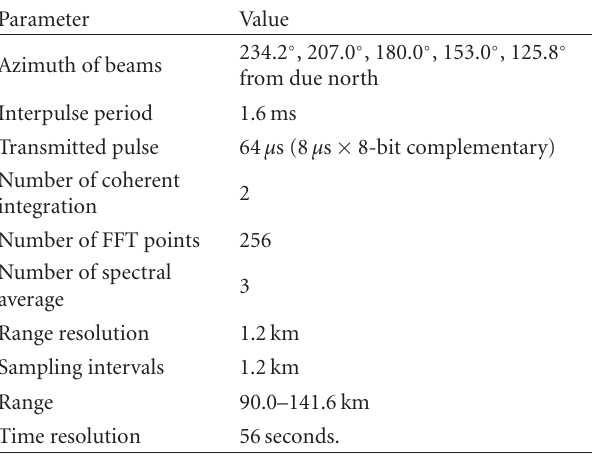
Table 2: Observational mode for E -region